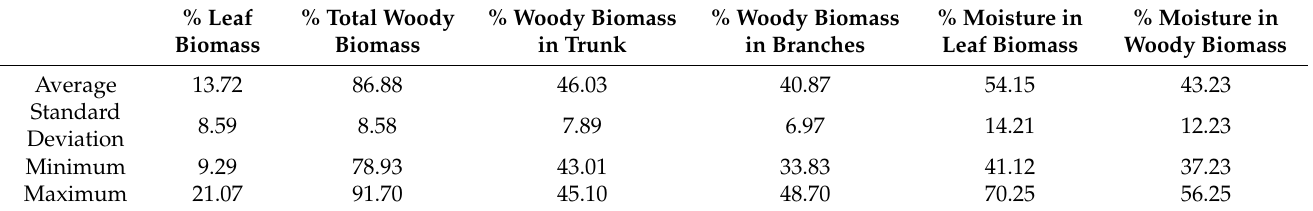
Table 2. Woody and foliar fraction and humidity.